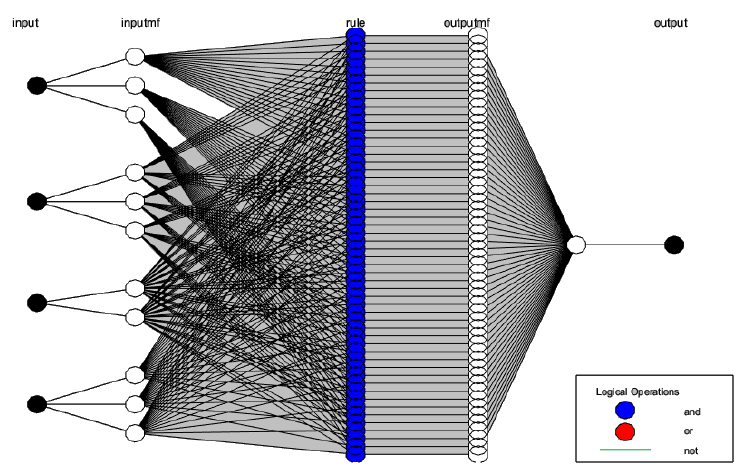
Figure 7. The ANFIS structure.